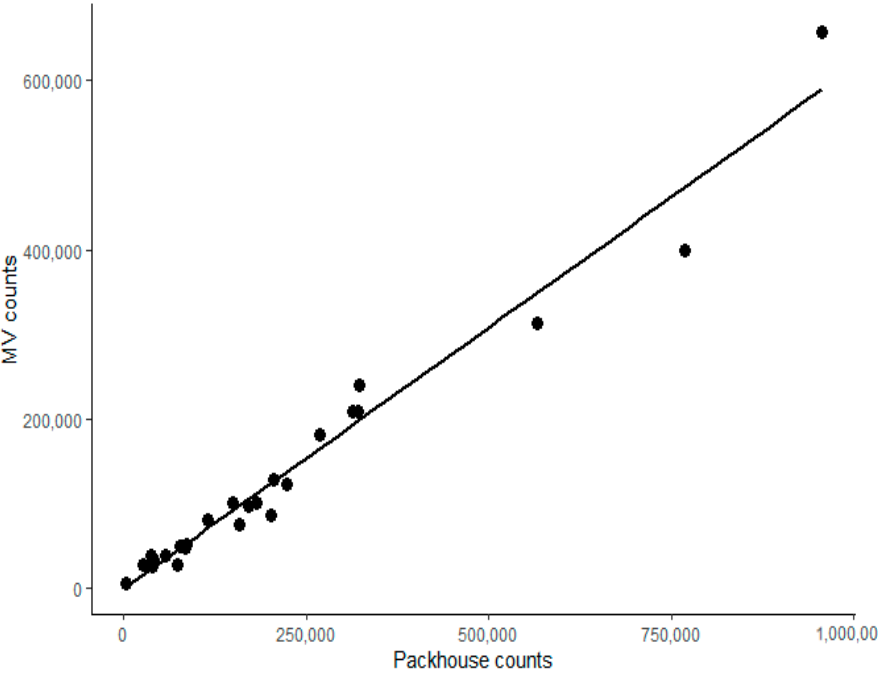
Figure 7. 2020–2021 season multi-view machine vision count of fruit per orchard fruit plotted against packhouse fruit count for 20 orchards from one farm. Data is fitted by a linear regression model, R 2 = 0.97, slope = 0.62, p < 0.001.